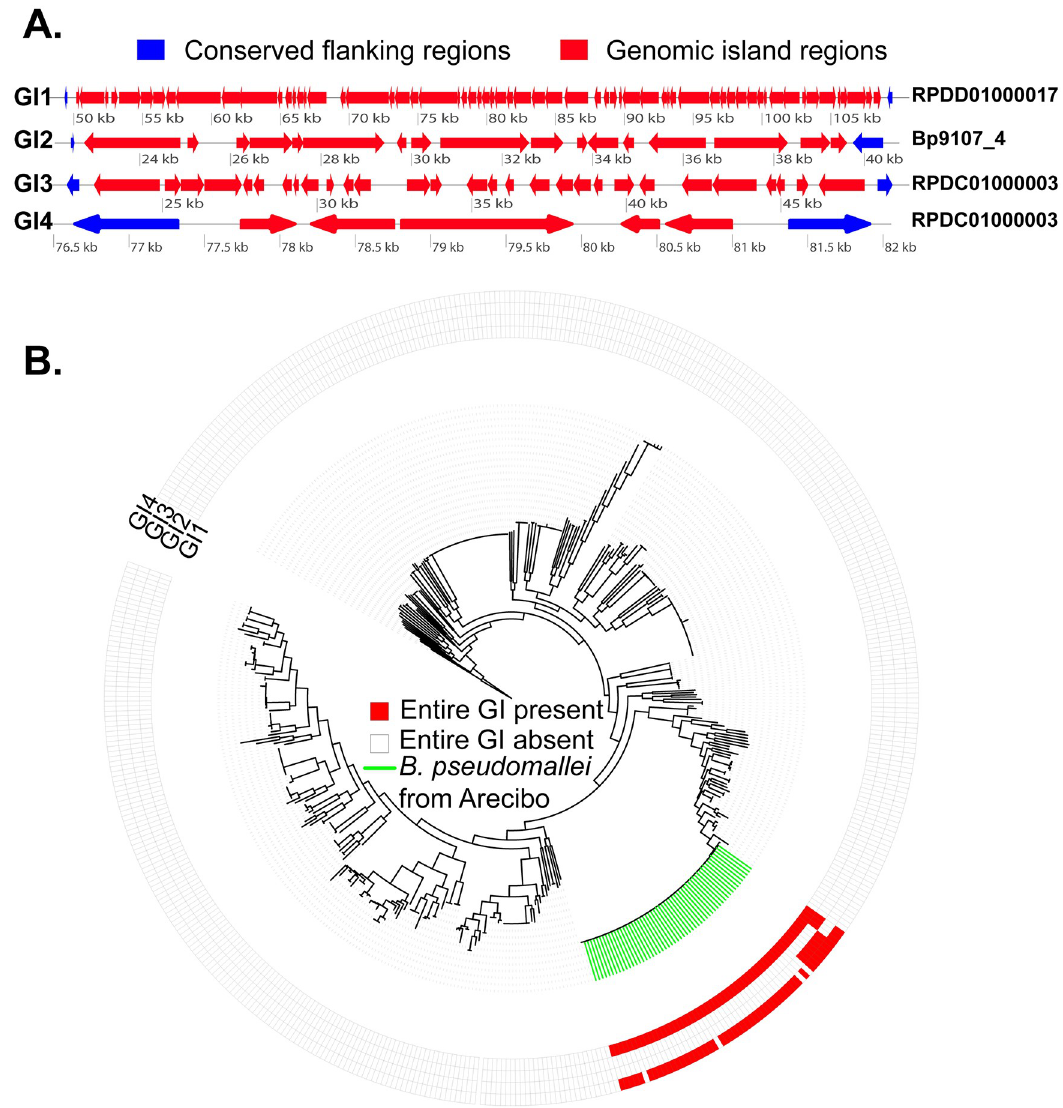
Fig 3. Genomic islands present in B . pseudomallei isolates from a single location in Puerto Rico. (A) Reveals the structure of the four novel B . pseudomallei genomic islands (GI1-4) that were discovered in this study; contig names are listed on the far right. The red arrows reflect B . pseudomallei genes found within the genomic islands and the blue arrows reflect conserved flanking regions commonly found in other B . pseudomallei strains. (B) Circular phylogeny with genomic islands mapped on the outside of the phylogeny. This phylogeny was constructed using the same 414 B . pseudomallei isolates used to generate Fig 2 plus the 53 additional B . pseudomallei isolates from site 23 that were not included in Fig